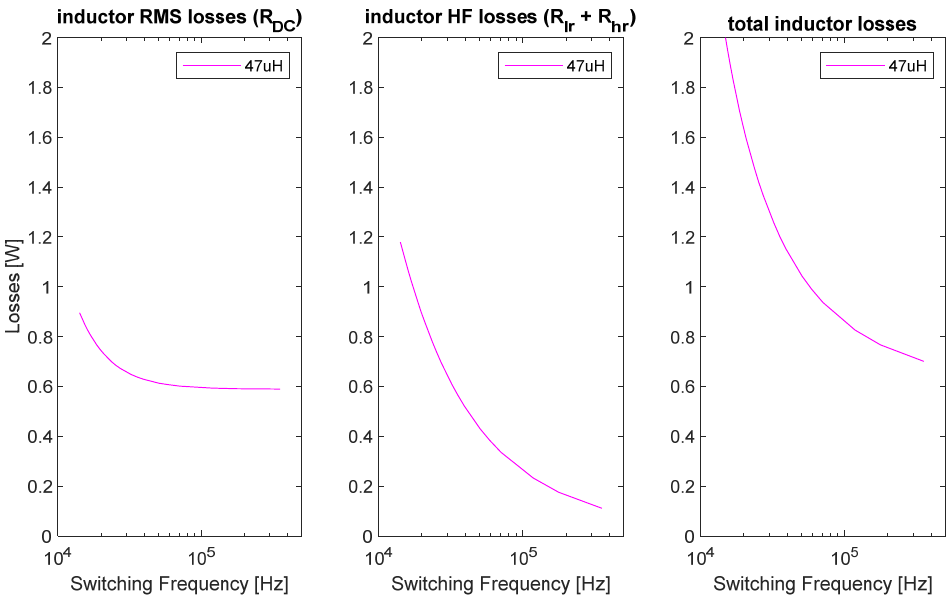
Figure 15. Inductor losses calculated for the two MSS1210 inductors of bidirectional full bridge converter working under 30 V input with 20 V output at 2.5 A.